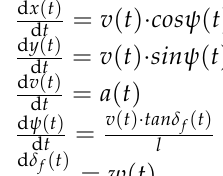
Table 3. The main symbols in the manuscript. Symbols Meanings ( x , y ) represents the vehicle coordinates, ψ represents the intersection ( x , y , ψ ) Angle between the head direction and coordinate axis v Velocity of vehicle a Acceleration of vehicle δ f Front-wheel angle of vehicle w Angular velocity of front wheel l The wheelbase length X free The obstacle-free space X obs The obstacle space U The control space s init Initial condition of vehicle s goal Goal region of vehicle λ Feasible trajectory T ( V , E ) A tree T containing nodes V and edges E U rep Repulsive force field d ( q , q obs ) Distance between the grid point q and obstacle q obs Q ∗ Influence radius of obstacles F max Maximum value of the repulsive